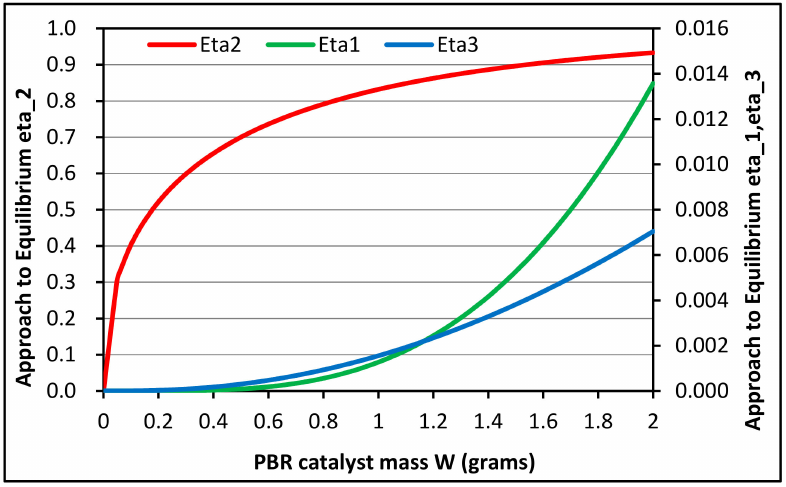
Figure 6. Equilibrium approaches ( η i ): T = 923 K, feed CH 4 / CO 2 = 0.5, GSV = 5.56 × 10 − 4 m 3 / s-kg, corresponding to Figure 5. “Eta i” = η i for Reactions 1 (DR), 2 (RWGS), 3